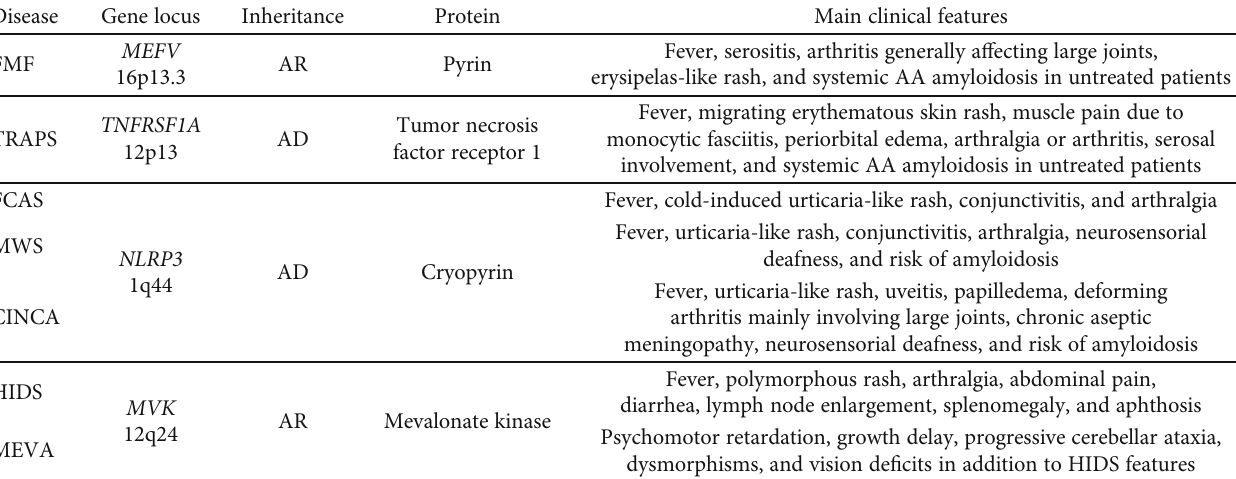
Table 1: Summary of the main genetic and clinical features of FMF, TRAPS, CAPS, and MKD. Disease Main clinical